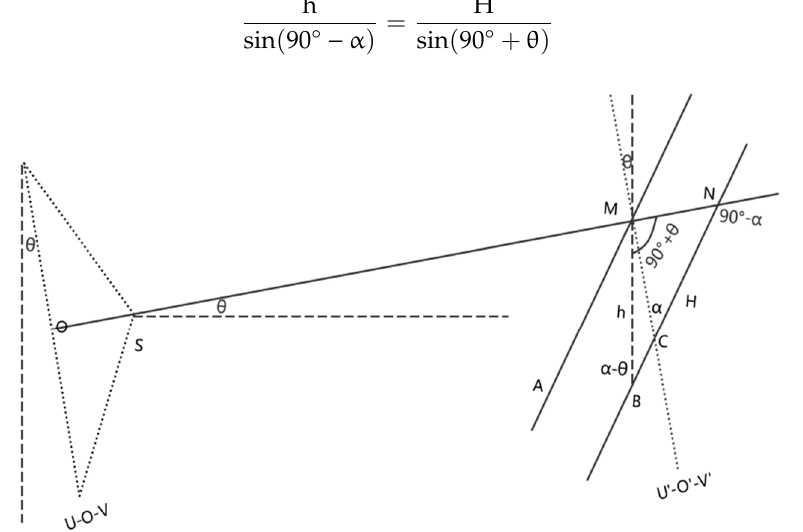
Figure 8. The central projection when the photographic base is non-level and the bar code is not vertical in another condition. The geometrical relationship of relevant parameters before and after settlement is also shown.